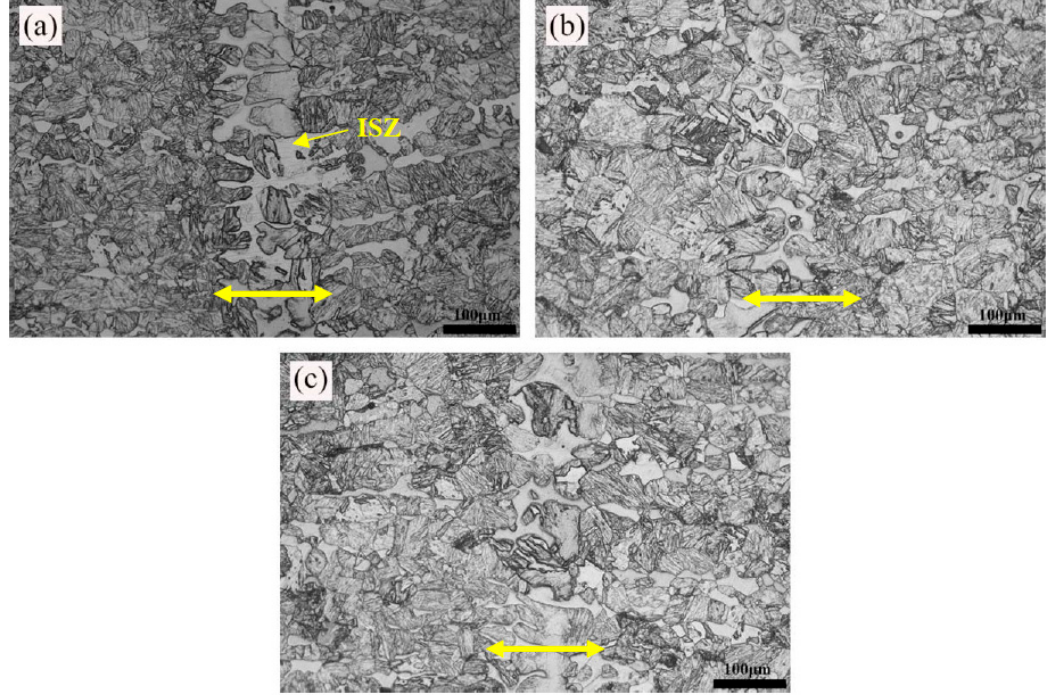
Metals 2022 , 12 , x FOR PEER REVIEW 10 of 19